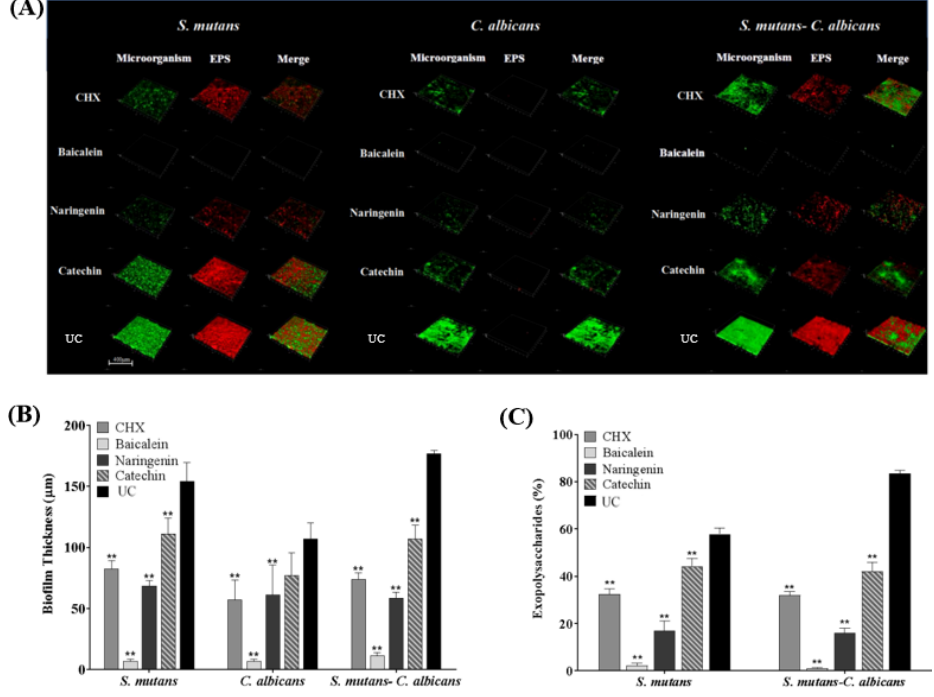
Figure 5. Representative CLSM staining images ( A ). Biofilm thickness ( B ) and EPS/bacterial or fungal ratio were calculated ( C ) (mean ± sd; n = 6; ** p < 0.01).